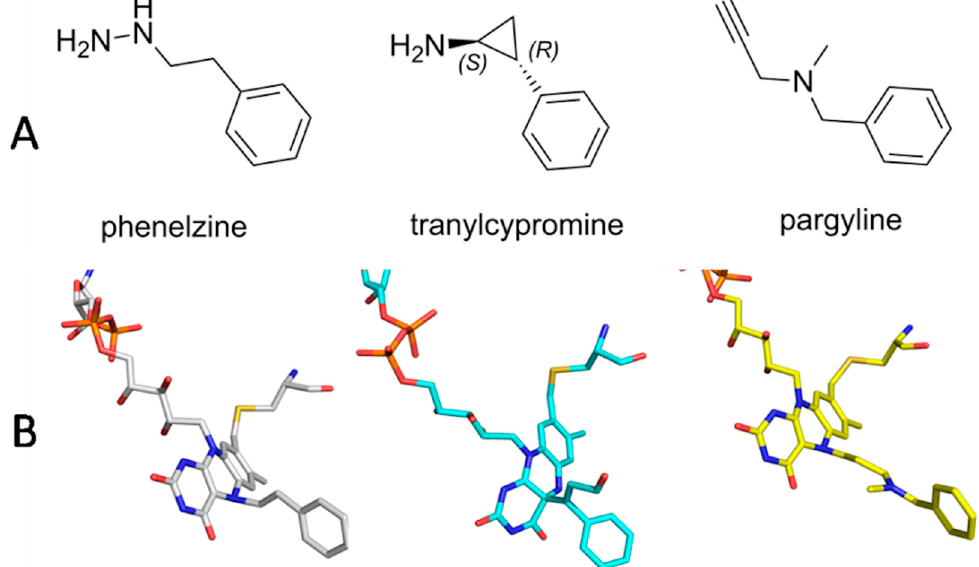
Figure 1. Structures of three non-selective monoamine oxidase (MAO) inhibitor drugs and adducts with flavin adenine dinucleotide (FAD). ( A ) The structures of phenelzine, tranylcypromine and pargyline, representing the three chemical classes of MAO inactivators. ( B ) Adducts of the three compounds covalently bound to FAD derived from X-ray structures of MAO-B. Phenelzine (left, PDB ID: 2VRM) [11] and pargyline (right, PDB ID: 1GOS) [12] both link to N5 of the FAD and tranylcypromine (middle, PDB ID: 2XFU) [13,14] is bonded to C4a of the FAD. Note that tranylcypromine is racemic, the (+)-enantiomer (1 S ,2 R -trans-2-phenylcyclopropylamine) being 60 times more potent in vitro, although chronic administration of either enantiomer results in MAO-B inhibition in vivo [15].